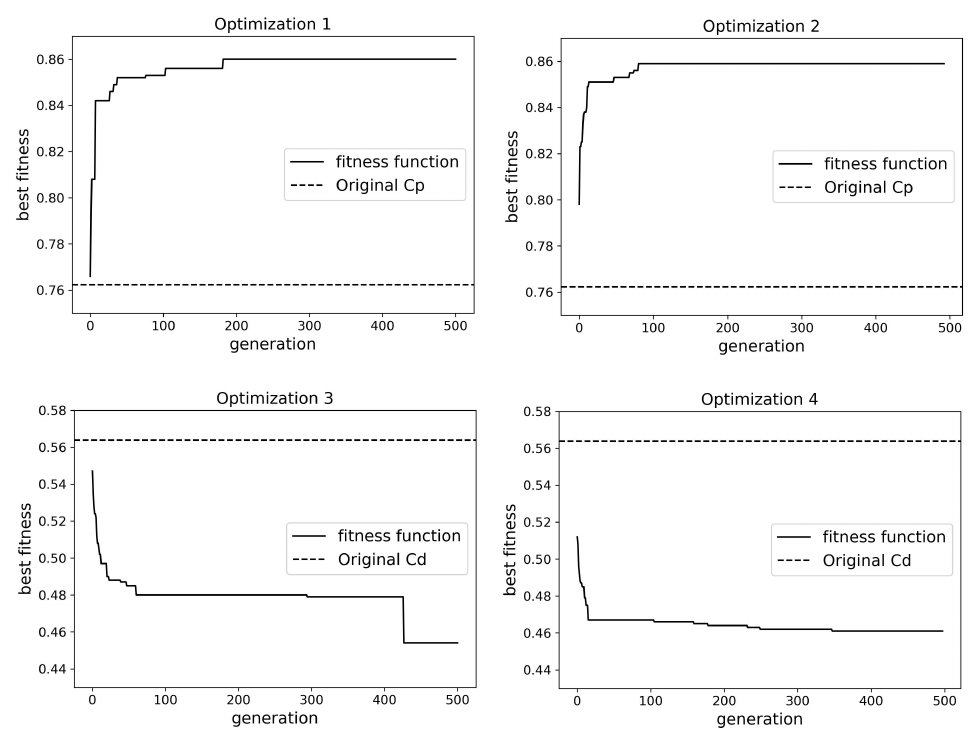
Figure A1. Convergence graphs for investigated optimization cases. When assessing C p , the goal is to maximize recovery, whereas for C d , the goal is to minimize losses. Dashed lines represent the initial